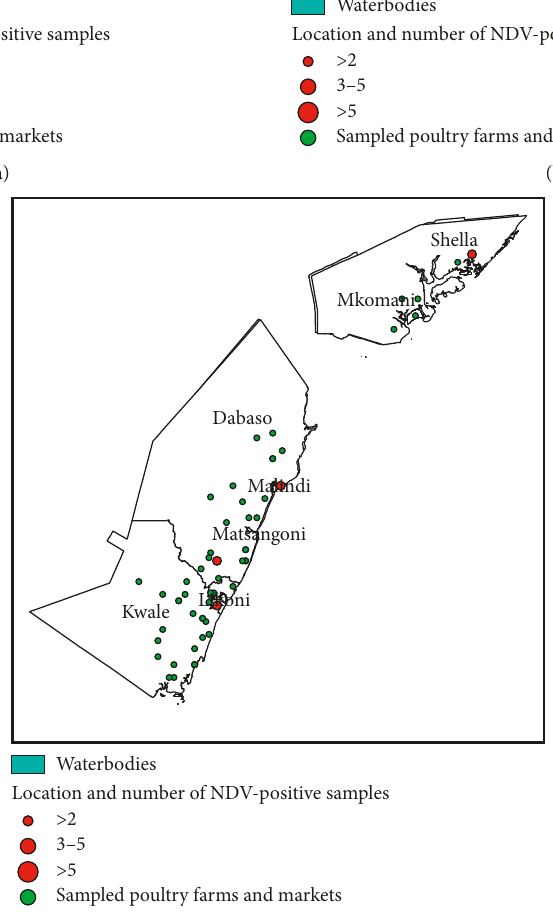
Figure 1: Geographical location of NDV-positive backyard poultry farms and live bird markets in Kenya, from November 2014 to March 2016: (a) a map of Kenya showing the location of sampled and NDV-positive live bird markets; (b) a map of the study region in Western Kenya showing the location of sampled and NDV-positive backyard poultry farms; (c) a map of Coastal region showing the location of sampled and NDV-positive backyard poultry